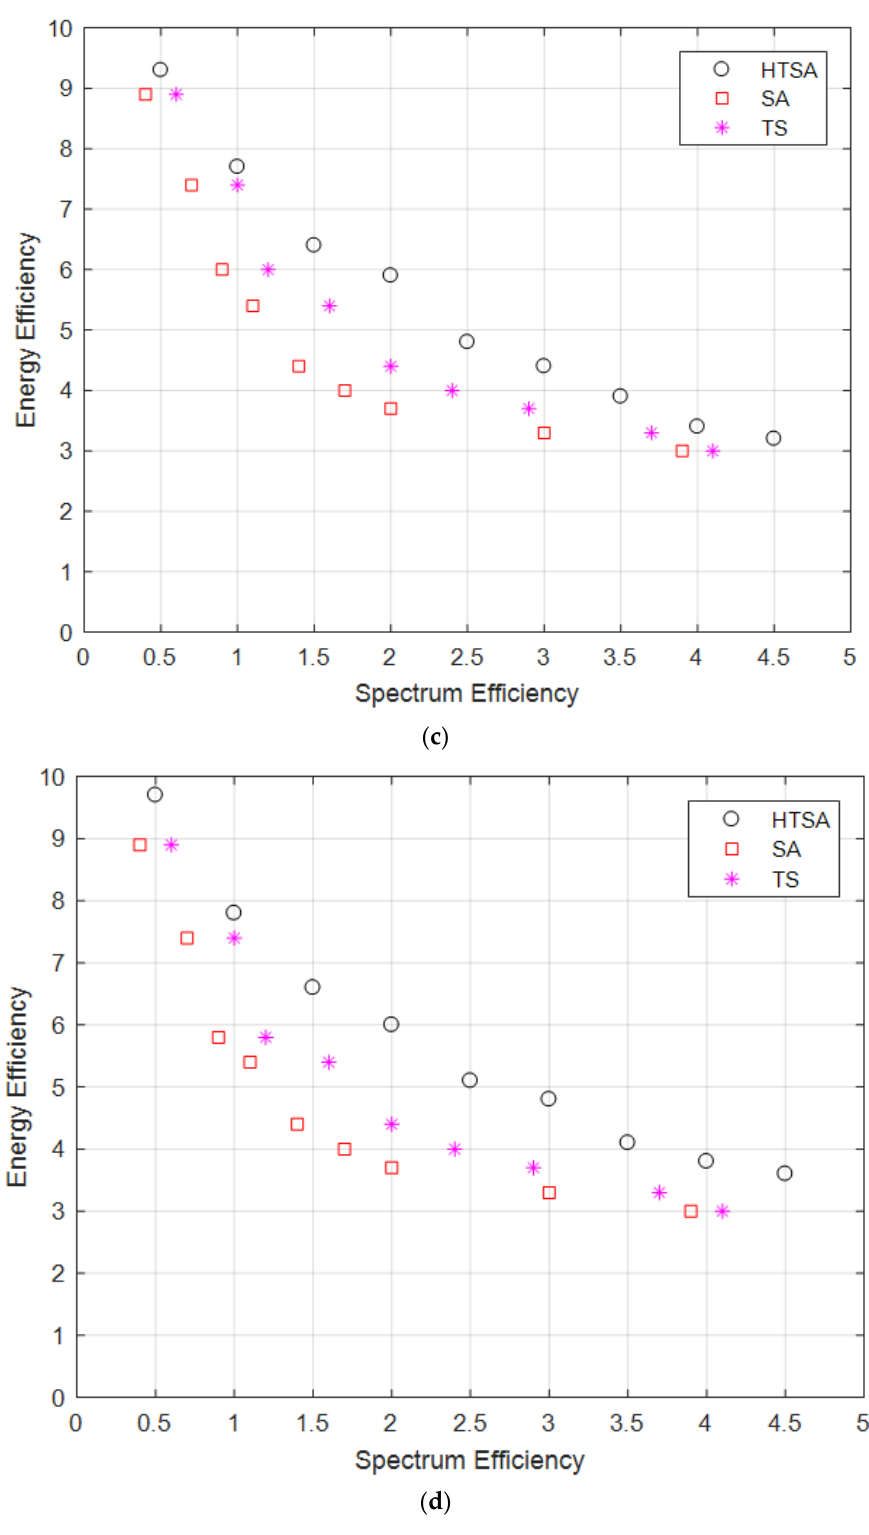
Figure 4. ( a ) 𝛾 = 4 dB . ( b ) 𝛾 = 6 dB . ( c ) 𝛾 = 8 dB . ( d ) 𝛾 = 10 dB . Figure 4. ( a ) γ = 4 dB. ( b ) γ = 6 dB. ( c ) γ = 8 dB. ( d ) γ = 10 Figure 5 represents the spectrum efficiency analyses with varying numbers of flows used by IoT nodes for different number of channels. The spectrum increased with in- creasing flows and vice versa. By using more flows, the spectrum utility is distributed on different flows due to increased spectrum efficiency. Figure 6 represents the energy effi-